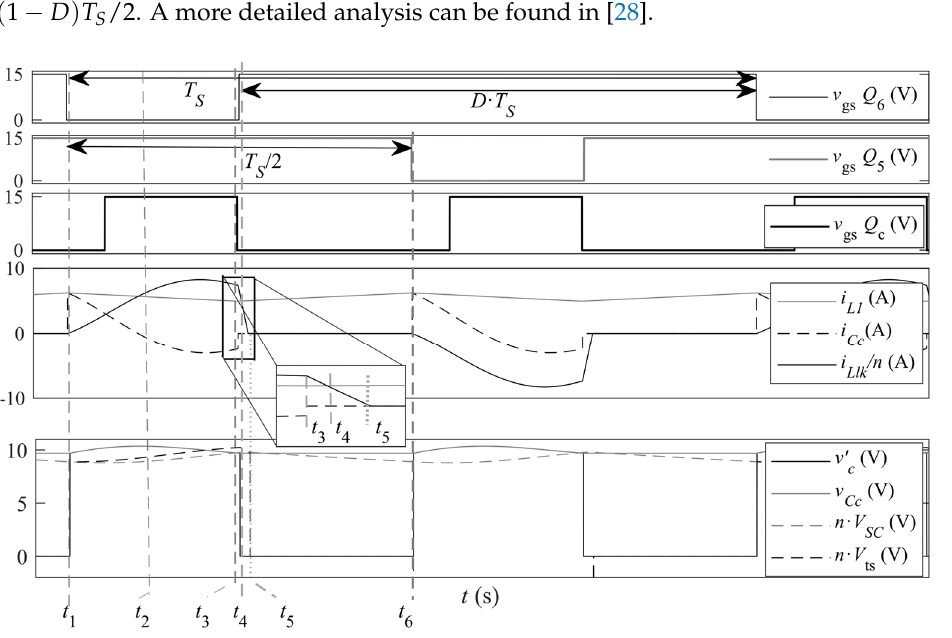
Figure 6. Boost-mode waveforms.